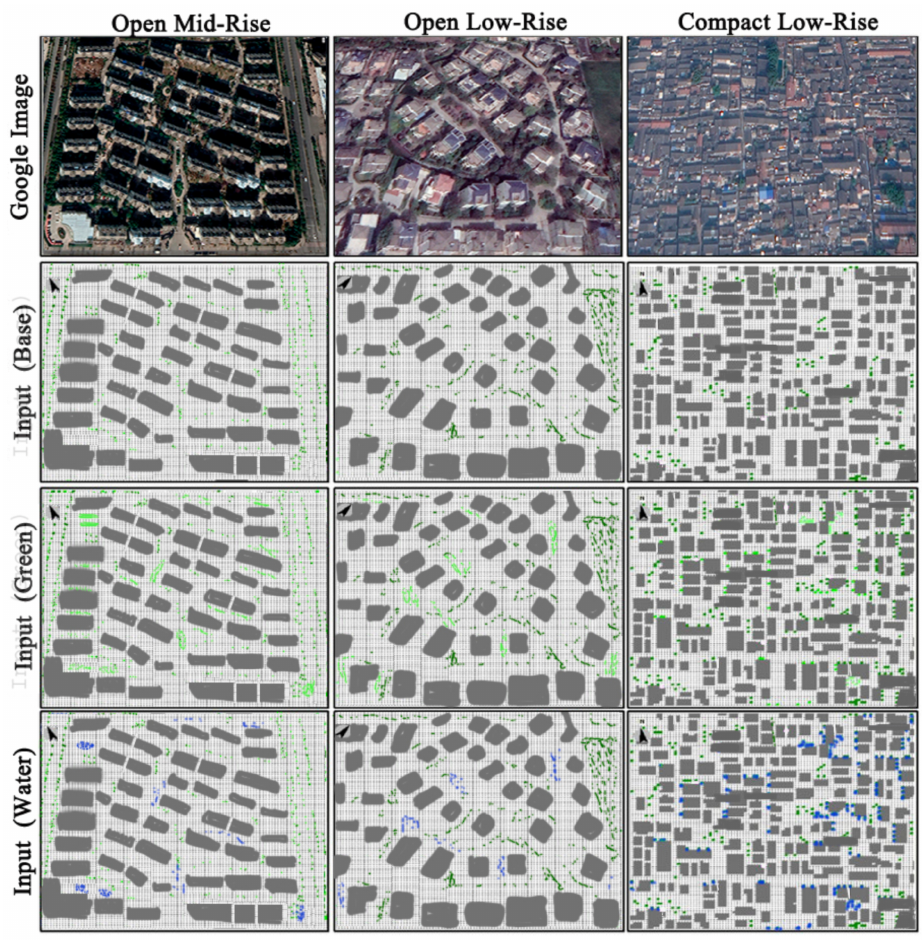
Figure 4. Input comparison of three UHI thermal heterogeneous environment models; open mid-rise: Hengdui, Huai‘an City; open low-rise: Yandu District Education Bureau, Yancheng City; compact low-rise: Xuansheng Temple, Yangzhou